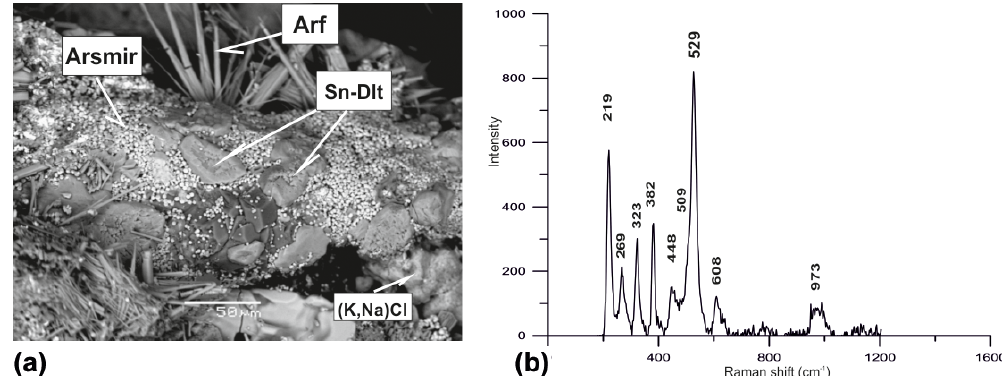
Figure 12. Patch-like crystals of the Sn analogue of dalyite (Sn-Dlt) on arsmirandite (Arsmir) in association with potassic-fluoro-magnesio- arfvedsonite (Arf) and Na-bearing sylvite [(K,Na)Cl]; BSE image (a) . Raman spectrum of randomly oriented sample of Sn analogue of dalyite from the Arsenatnaya fumarole (b)